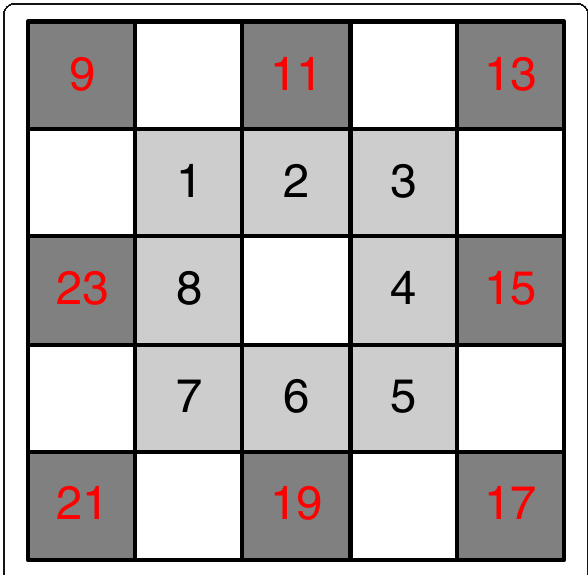
Fig. 2, representing the linear function of the segment, respectively representing the size of the gray level belonging to the three fuzzy sets of dark, gray, and bright. Three membership degrees are found for the gray levels in each grayscale